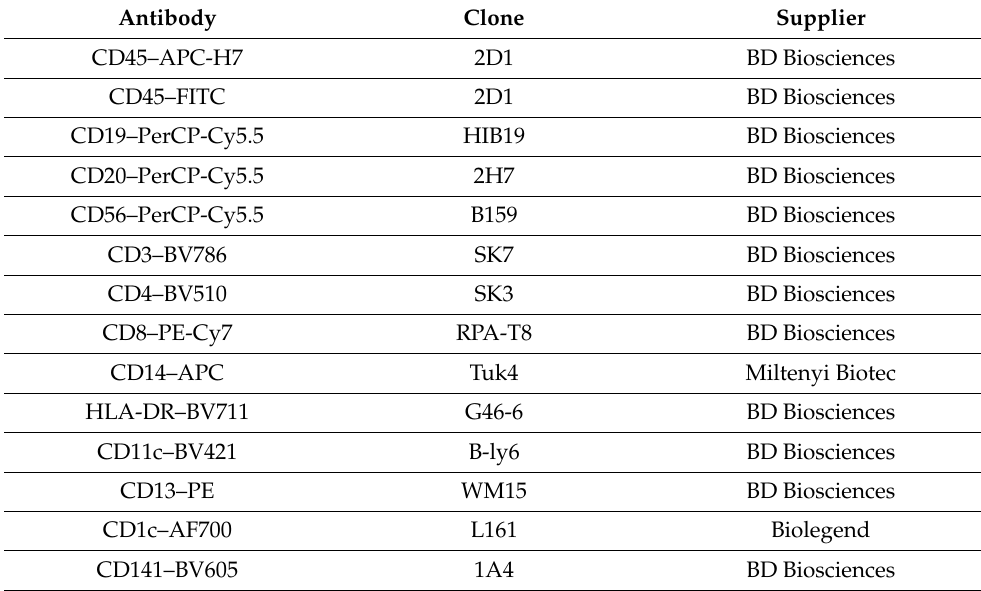
Table 2. Antibody panel employed for leukocyte